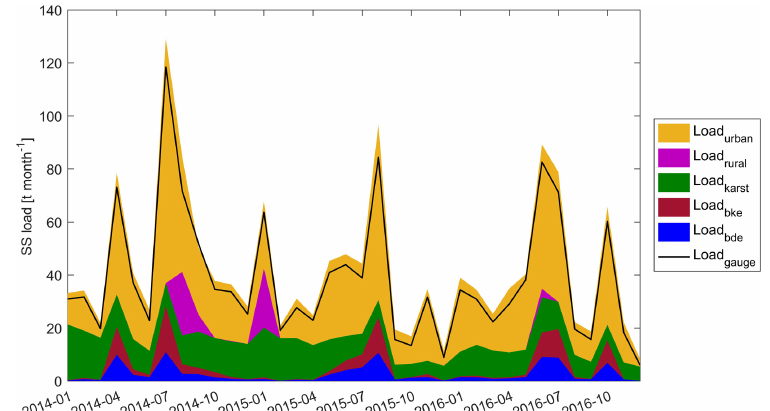
Figure 7. Monthly mean suspended-sediment load from different processes, calculated using the model results of 2014–2016. Load gauge , Load urban , Load rural , and Load karst are the monthly mean suspended-sediment load at the gauge and from urban areas, rural areas, and the karst system. Load bke and Load bde represent monthly mean suspended-sediment load from bank erosion and bed erosion for the entire river network, respectively. The area above the line of Load gauge is the monthly mean deposition, Load dep